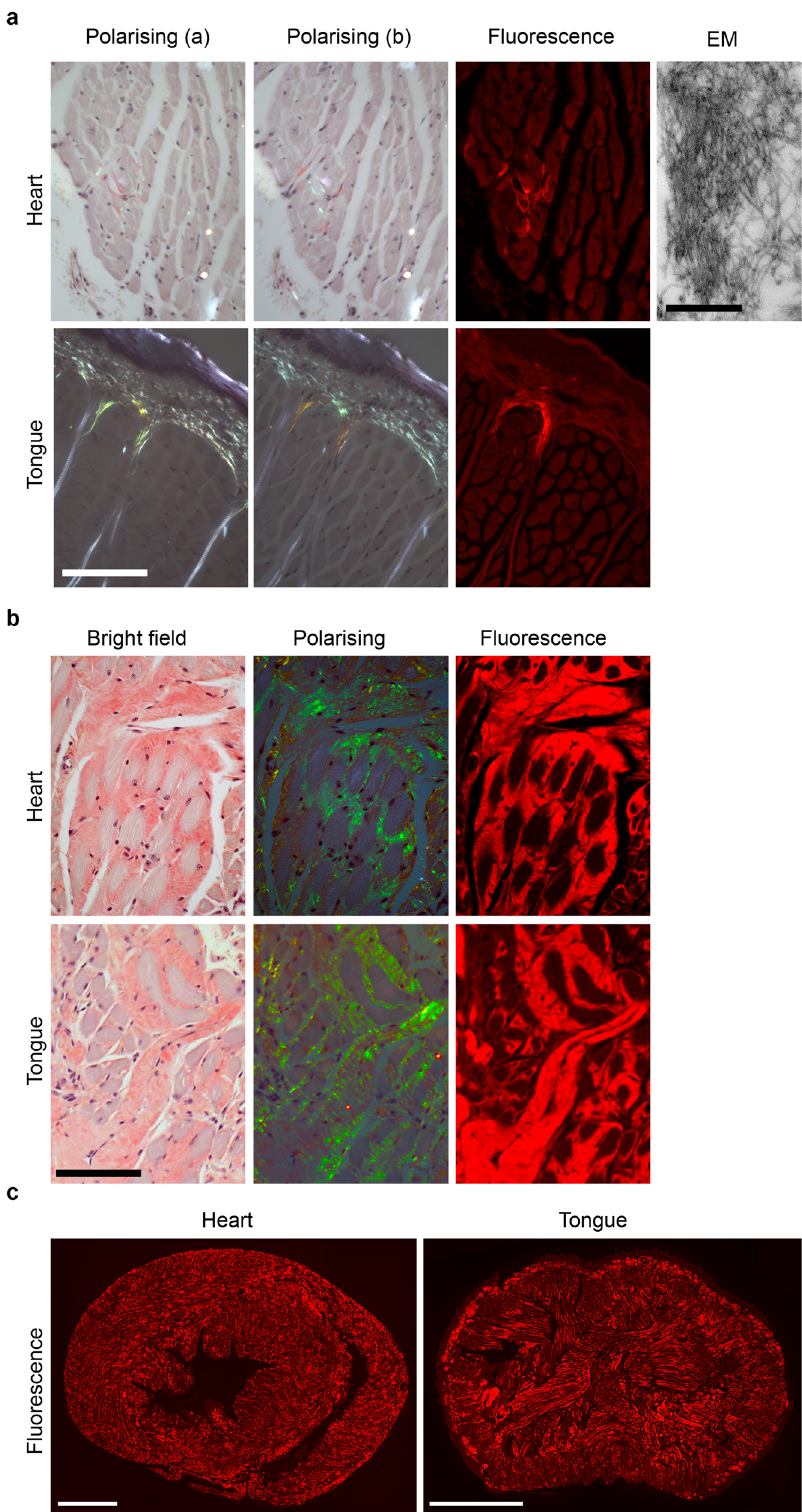
Fig. 2 Amyloid in seeded mice of lines O5 and N4. Amyloid demonstrated by the pathognomonic red-green birefringence of Congo red stained sections viewed by polarising microscopy under intense illumination; background white birefringence was generated by myo fi brils. The full extent of the amyloid is readily appreciated in the Congo red fl uorescence images. a Minor but unequivocal amyloid deposits in the heart and tongue of a male line O5 mouse 7 months after seeding, representative of the maximum amyloid loads in mice of this line ( n = 53 amyloidotic mice). The electron micrograph shows the unbranching ~10 nm diameter morphology characteristic of genuine amyloid fi brils. b Copious amyloid deposits in heart and tongue of a line N4 transgenic male mouse 6 months after seeding. c Low magni fi cation Congo red fl uorescence images showing the typical extent of amyloid deposits in heart and tongue of line N4 transgenic mice seeded 6 months prior to sample collection. b , c are representative of typical amyloid loads in mice of this line analysed 6-7 months after seeding ( n = 10). Scale bars: a , 100 µ m (light micrographs) and 500 nm (EM); b , 100 µ m; c , 1